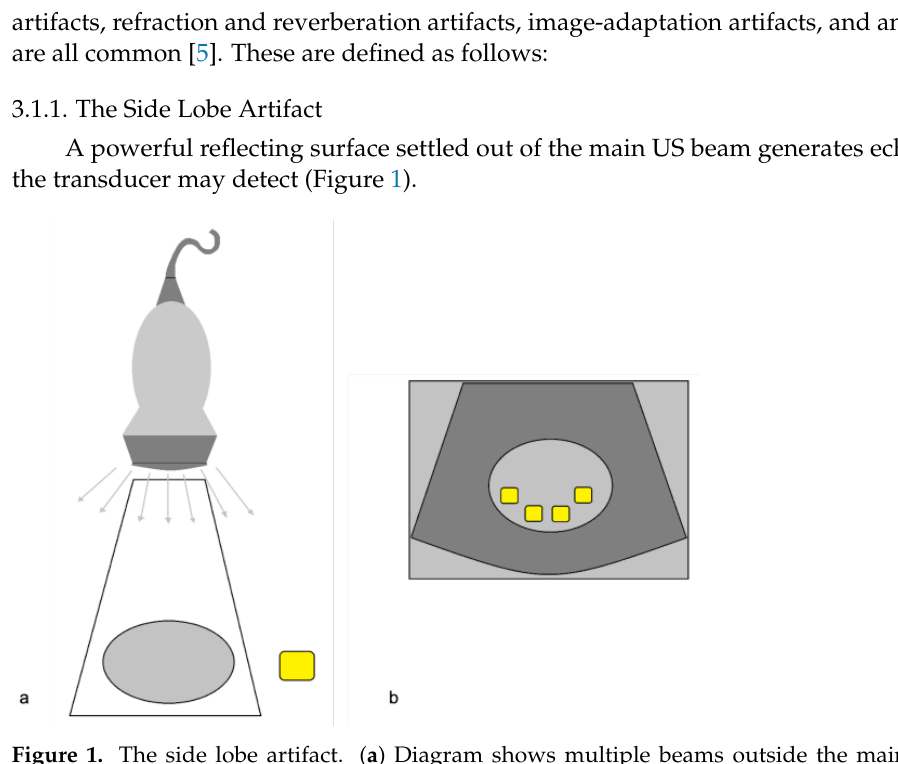
Figure 1. The side lobe artifact. ( a ) Diagram shows multiple beams outside the main US axis encountering an object (yellow box); ( b ) The display assumes that the return echoes that come from outside the main axis are mistakenly understood as coming from the main axis itself, and therefore misplaces and duplicates the structure (multiple yellow boxes) in the context of the target image. Modified from Feldman MK et al. [5].